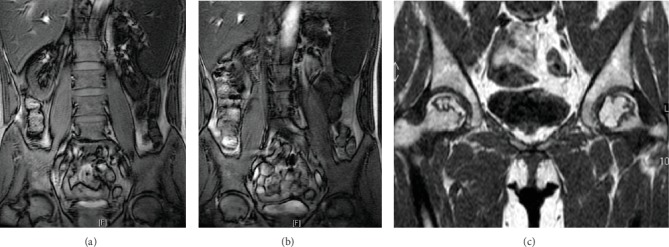
A 56-year-old male developed ONFH after DBRs treatment for 76.4 months. (a, b) Coronal magnetic resonance image before DBRs. (c) Coronal magnetic resonance image after cumulative dose of 4000 mg dexamethasone for 76.4 months. ONFH: osteonecrosis of femoral head; DBRs: dexamethasone-based regimens.